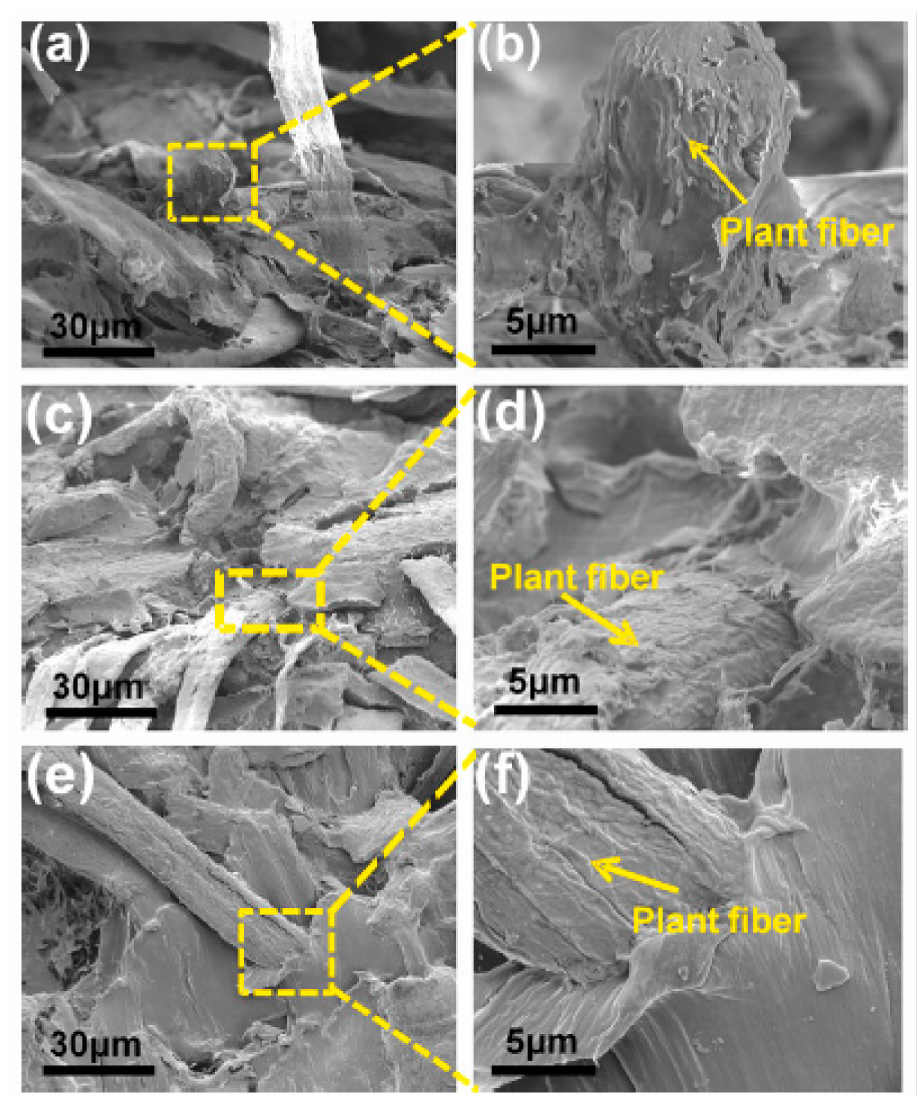
Figure 15. SEM of waste paper (WP)/PBS composites at various WP contents after flexural fracture: ( a ) and ( b ) 10 wt.% WP, ( c ) and ( d ) 30 wt.% WP, and ( e ) and ( f ) 60 wt.% WP [125]. Copyrights obtained from